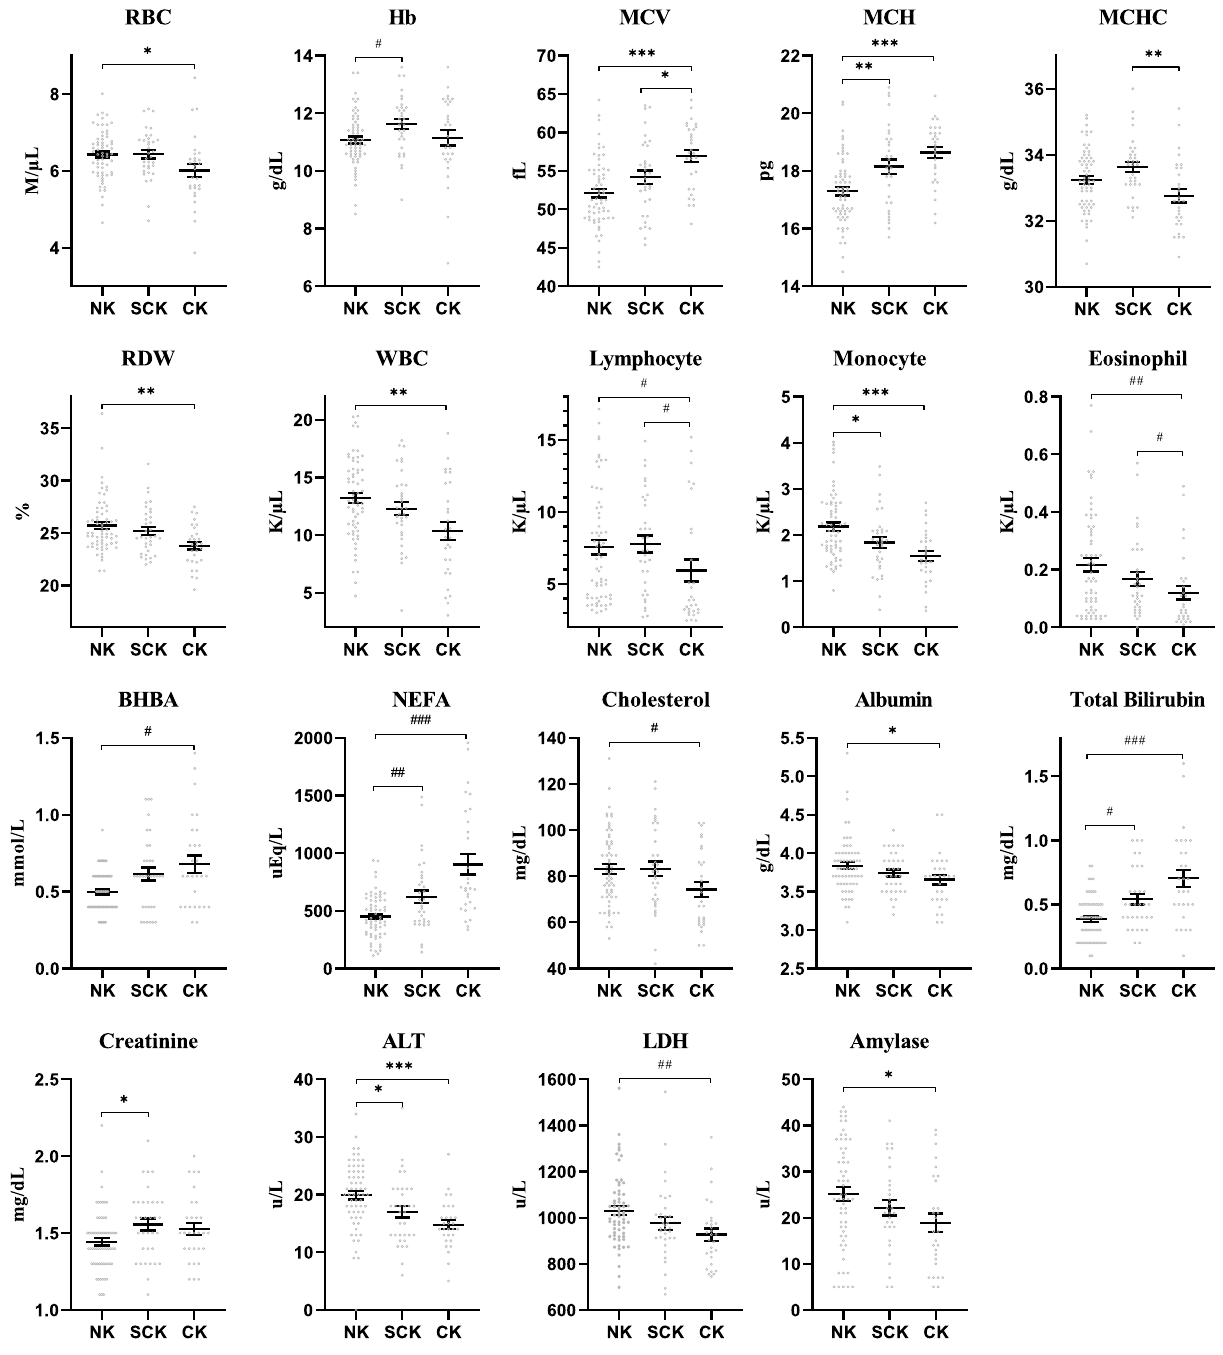
Figure 1. Hematological parameters including erythrocyte and leukocyte count and significant serum biochemical parameters. The results are expressed as mean ± standard error of the means. Statistical significance was expressed in one of the following two ways: one-way ANOVA with post-hoc Tukey honestly significant difference (* p < 0.05; ** p < 0.01; *** p < 0.001) or Kruskal–Wallis test and Mann–Whitney U test with Bonferroni’s method ( # p < 0.017; ## p < 0.003). ALT, alanine transaminase; BHBA, β-hydroxybutyrate; CK, clinical ketosis; Hb, hemoglobin; LDH, lactate dehydrogenase; MCH, mean corpuscular hemoglobin; MCHC, mean corpuscular hemoglobin concentration; MCV, mean corpuscular volume; NEFA, non-esterified fatty acids; NK, non-ketosis; RBC, red blood cell; RDW, red cell distribution width; SCK, subclinical ketosis; WBC, white blood